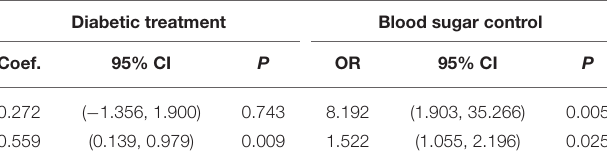
TABLE 5 | Associations between performance-based salary system incentive and performance on diabetes patient management care at facility level. Diabetic treatment Blood sugar